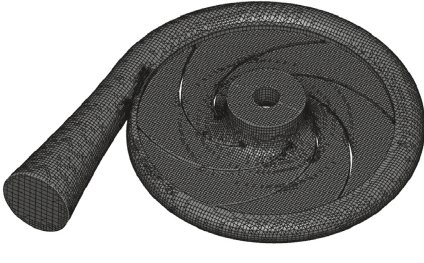
Figure 2: Grid division. Table 3: Grid independence